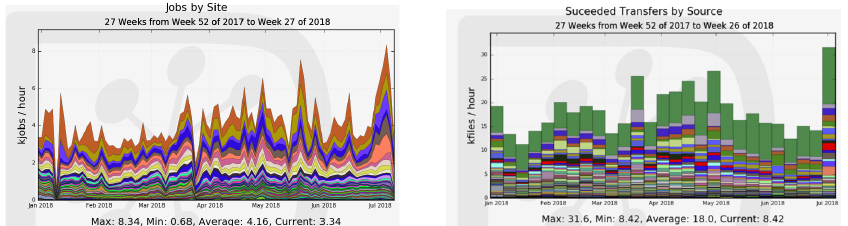
Figure 5: Belle II computing results: (a) concurrent compute jobs and (b) concurrent transfers (including